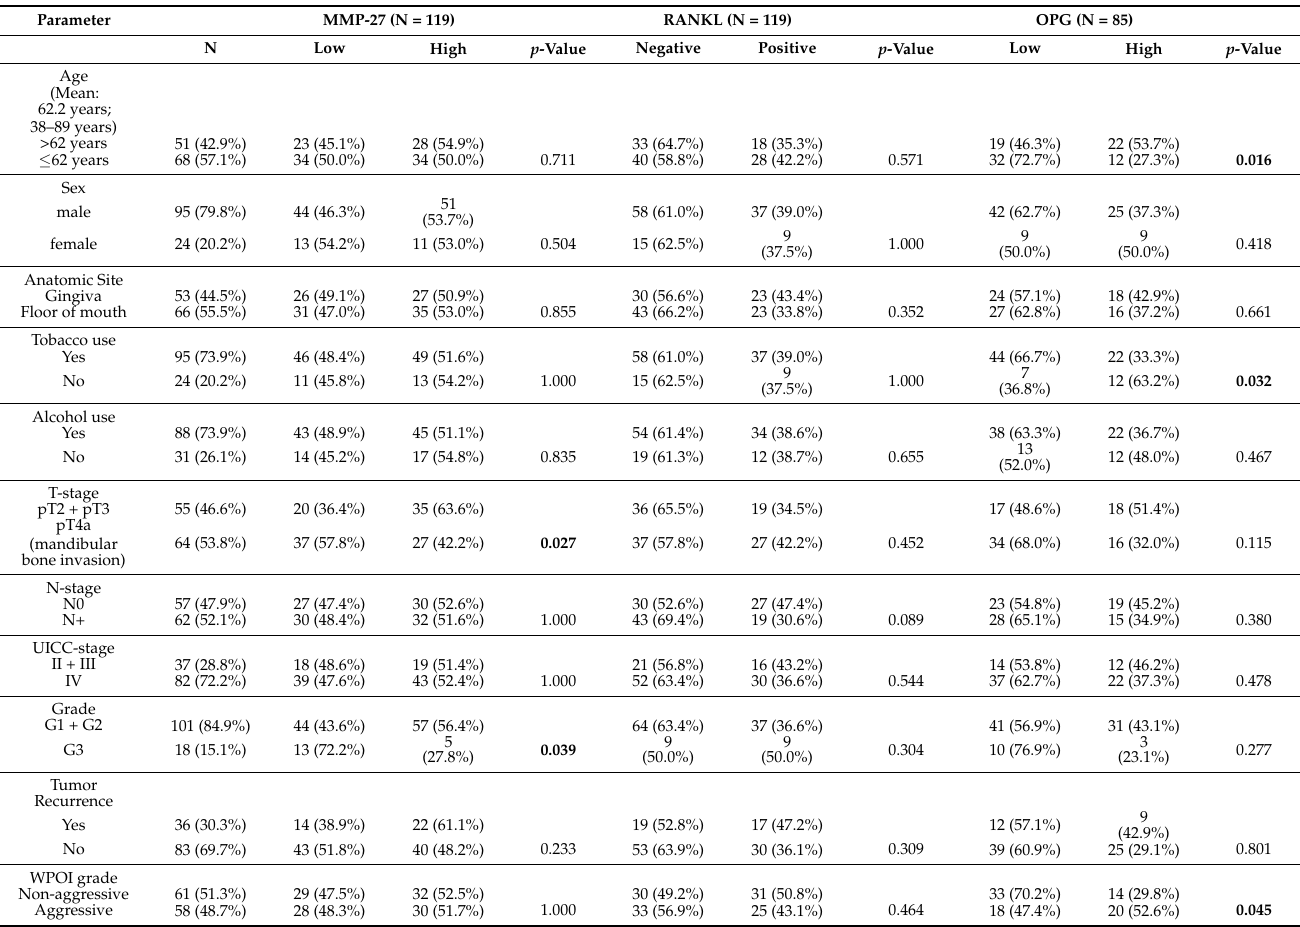
Table 1. Expression of MMP-27, RANKL and OPG and association with clinical and pathological parameters. All patients presenting with pT4a had an invasion of the mandibular bone. Significant p -values are highlighted in